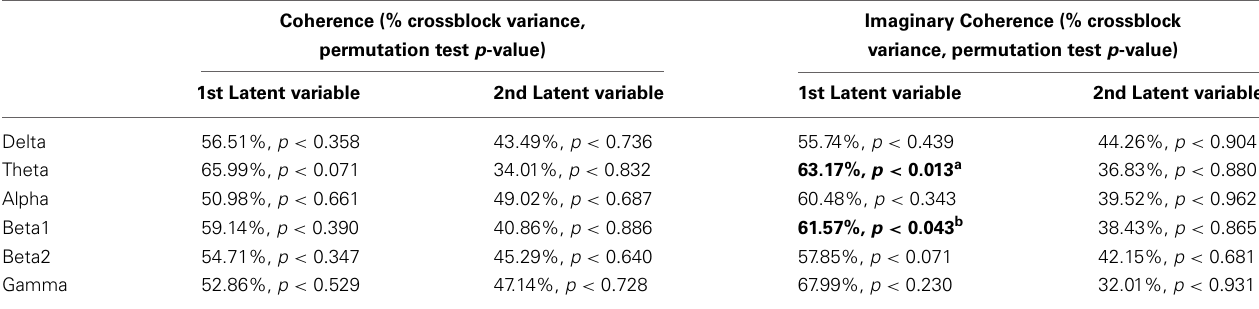
Table 2 | Results of the Partial Least Squares Analysis of Coherence/Imaginary Coherence by state (Hypnosis vs. Pre-hypnosis) and group (“High Susceptibles” vs. “Low Susceptibles”).